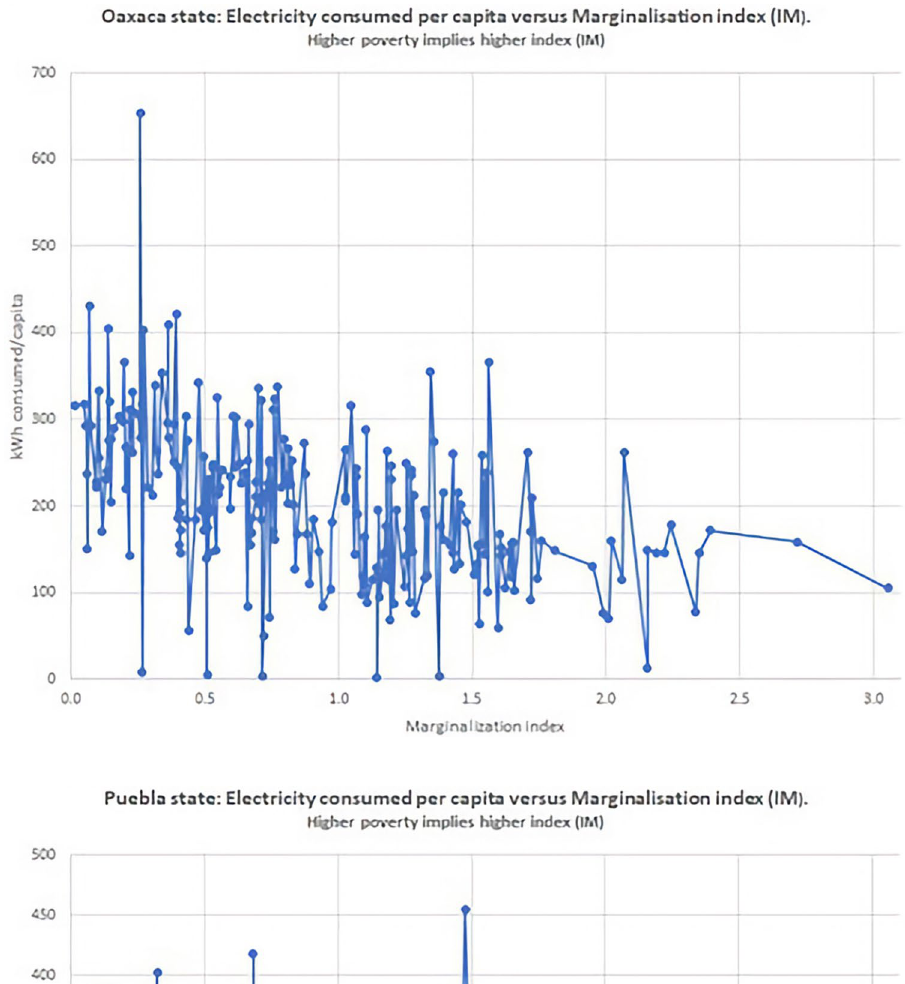
Fig. 15 Relation between Marginalisation Index (IM) and Electricity consumed per capita in Oaxaca state